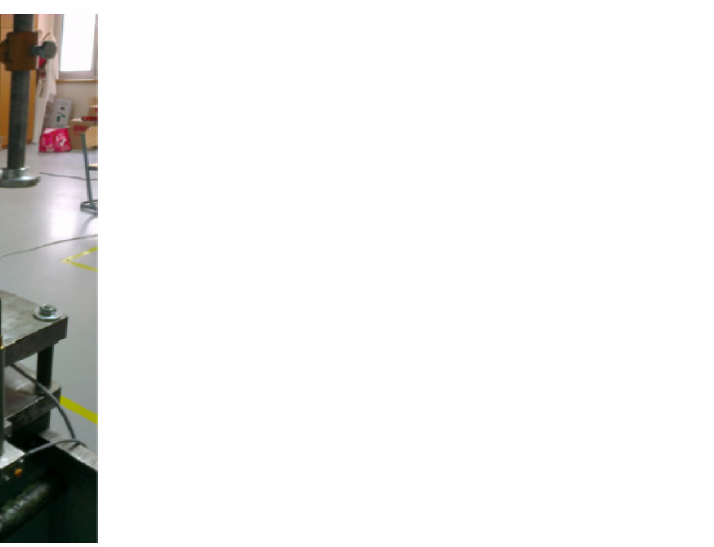
Figure 2. Specific experimental equipment for the production of briquettes. Source Reprint with permission [53]; Copyright 2021, Elsevier.